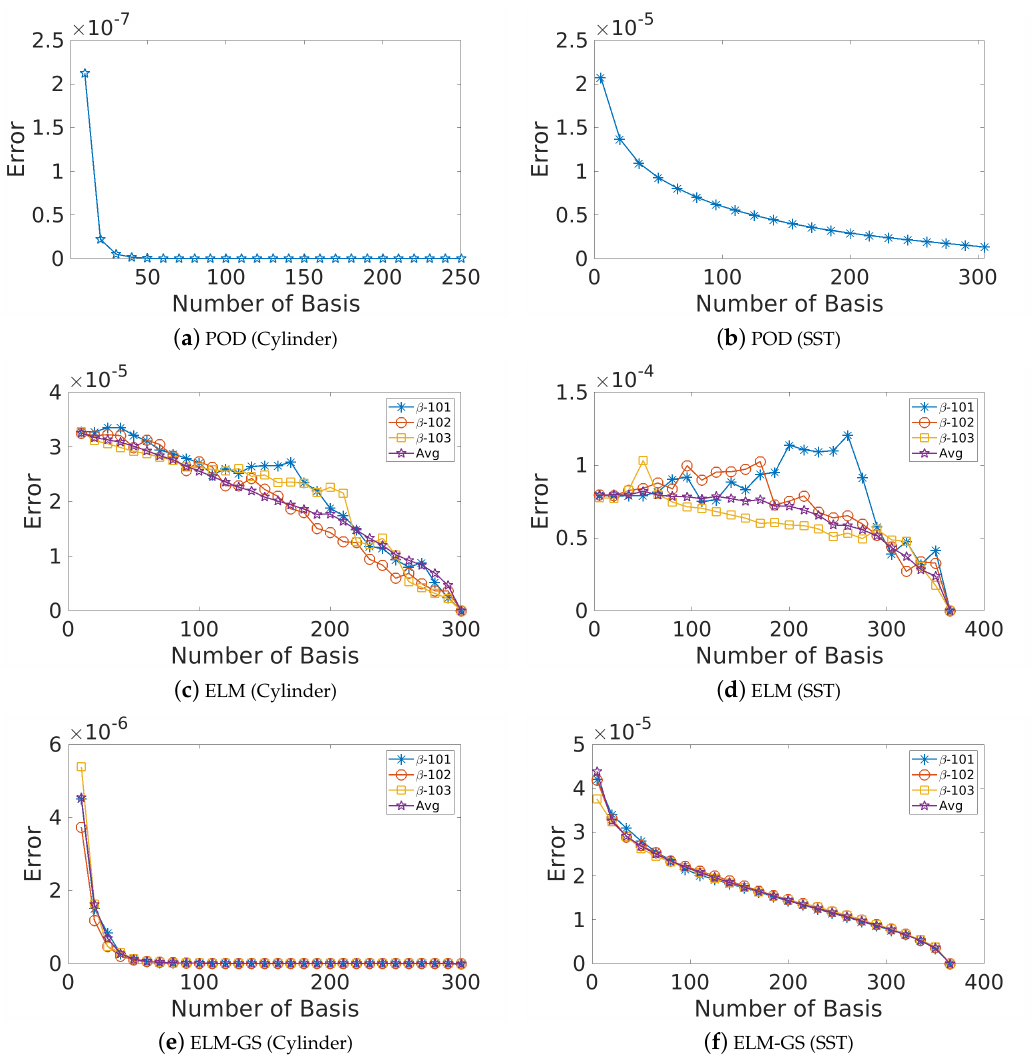
Figure 10. Plots showing how the error decays with the increase of basis number for all three cases POD, ELM and ELM-GS for both cylinder wake data (left column) and sea surface temperature (SST) data (right column). For ELM and ELM-GS, the different realizations corresponding to the different random seeds used for the network weights in the ELM (SLFN) training are shown, as well as the average error over 20 different training